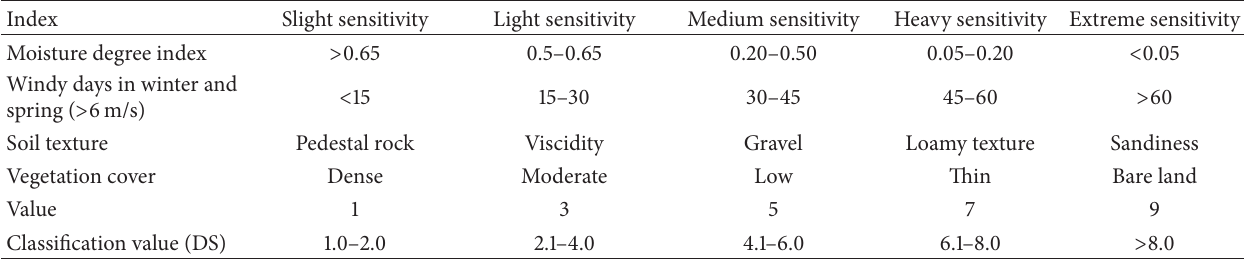
Table 3: Soil desertification sensitivity standard